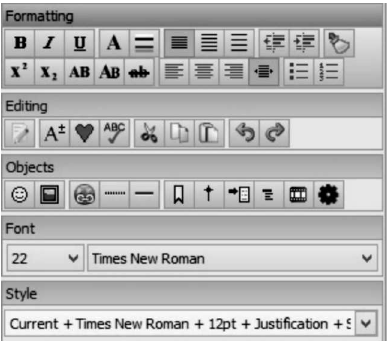
Figure 2. Editing tools in the Tools bar